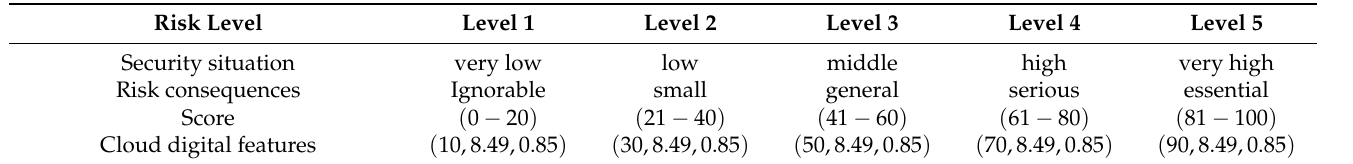
Table 4. Risk evaluation criteria and standard cloud digital features.